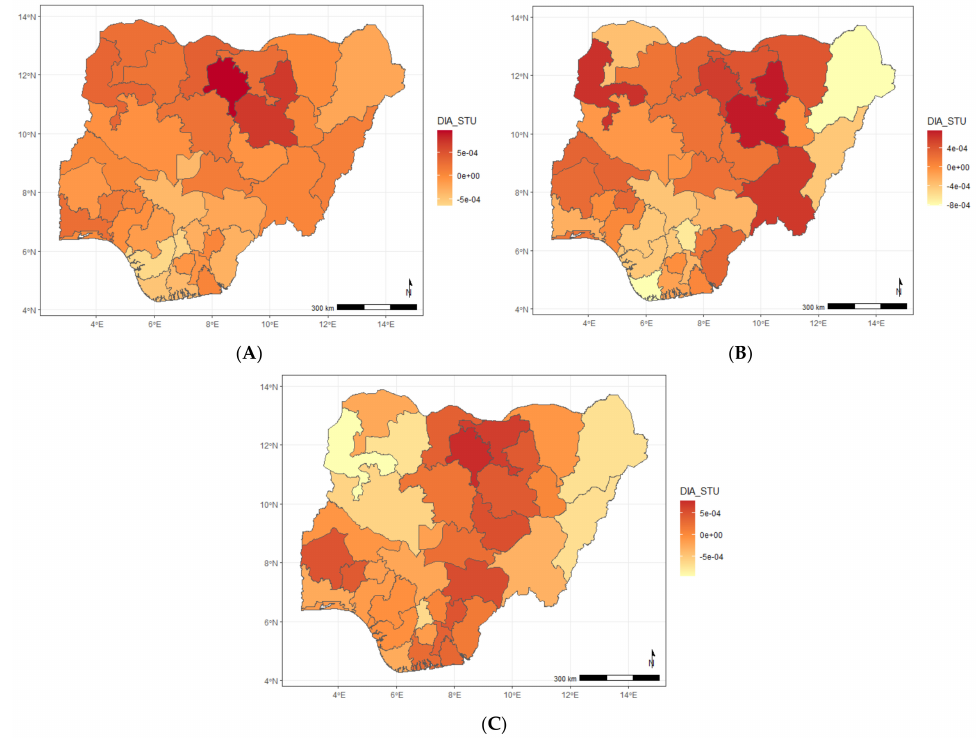
Figure A6. Maps showing posterior estimates of the diarrhoea and stunting spatial shared effect by year of NDHS implementation; ( A ) 2008, ( B ) 2013, ( C )